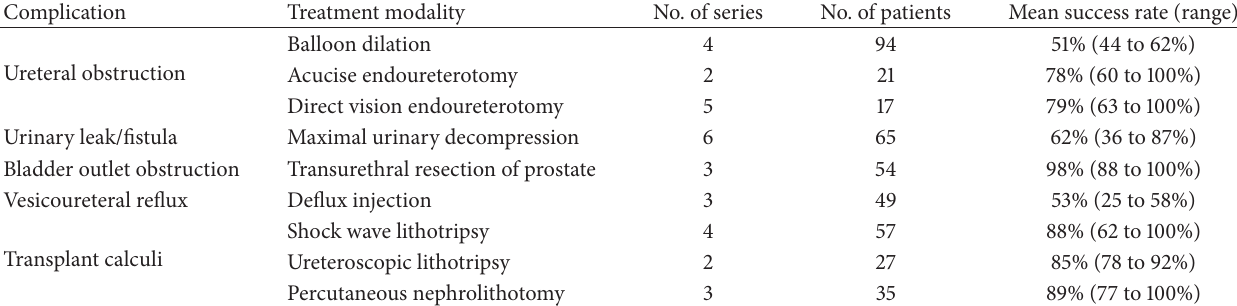
Table 1: Summary of case series by transplant complication and endourologic treatment